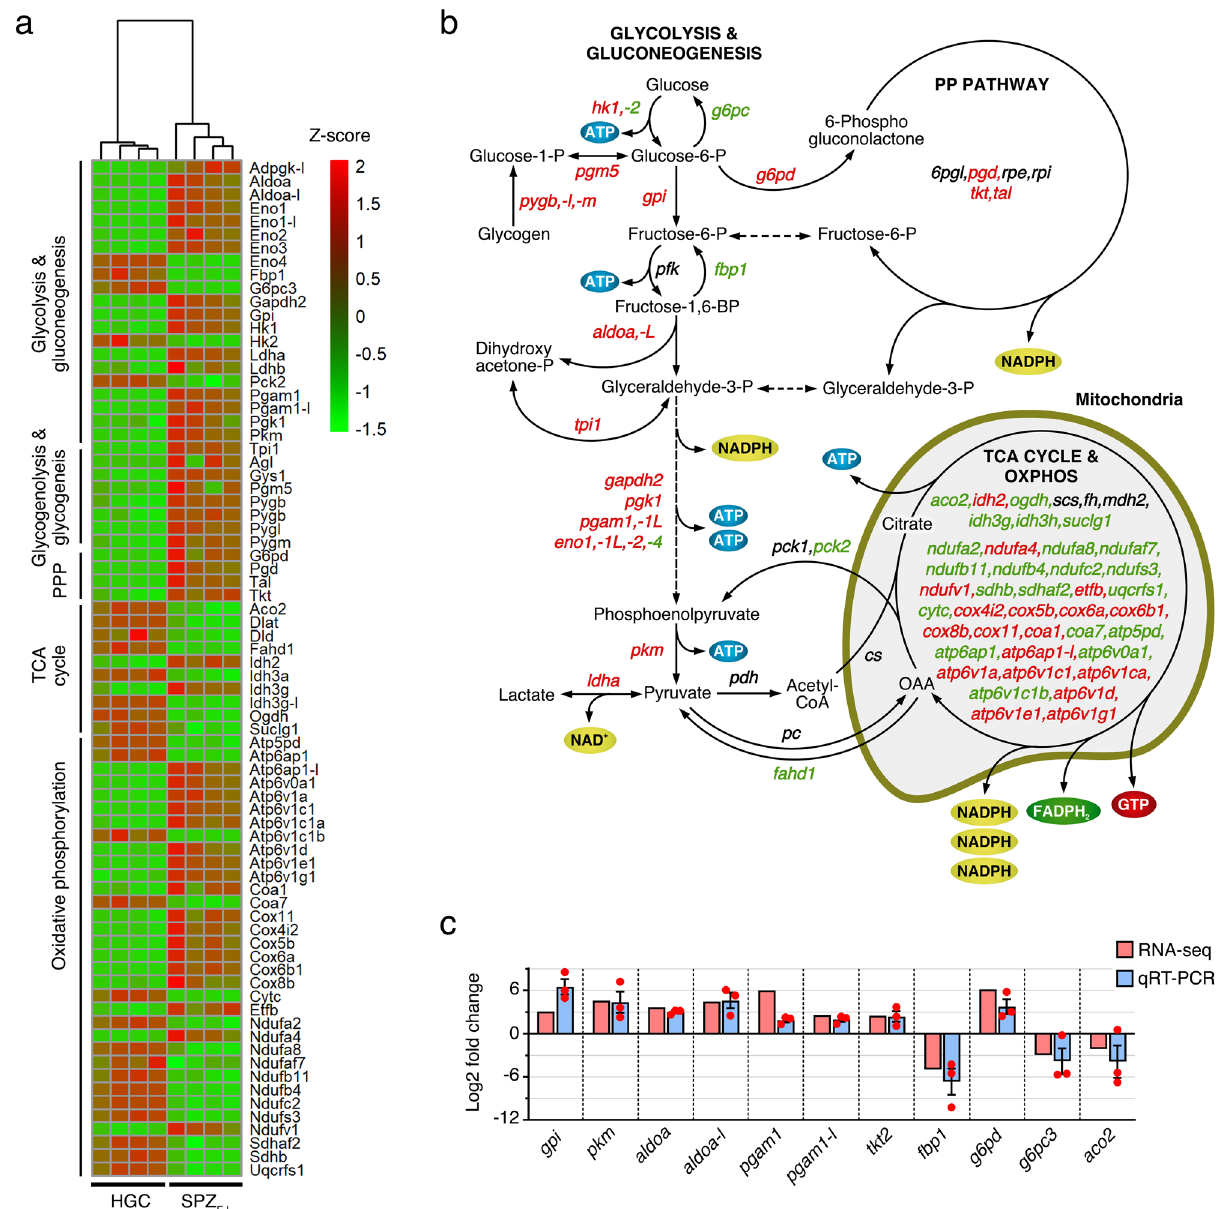
Figure 5. Analysis and mapping of DEGs potentially involved in respiratory pathways in seabream spermatozoa. ( a ) Hierarchical clustering heatmap of RNA-seq expression z-scores computed for genes encoding enzymes potentially involved in carbohydrate metabolism, penthose phosphate pathway (PPP), tricarboxylic acid (TCA) cycle, and oxidative phosphorylation (OXPHOS), that are differentially expressed ( p -adj < 0.01; Log2 fold change > 1) between HGC and SPZ EJ . The map was generated with the ‘pheatmap’ R package (https:// CRAN.R- proje ct. org/ packa ge= pheat map). ( b ) Schematic diagram of the biochemical pathways of glycolysis/ gluconeogenesis, PPP, TCA cycle and OXPHOS. Enzyme-coding DEGs in green and red color denotes downregulation and upregulation, respectively, whereas black color indicates no change in the expression levels. The diagram was generated using CorelDRAW Graphics Suite 2021.5 (https:// www. corel draw. com/). ( c ) Validation of the changes in expression of 11 selected genes classified into respiratory pathways by qRT- PCR. Data from qRT-PCR are the mean ± SEM ( n = 3 pools of 3 different fish each) and were plotted using the GraphPad Prism v8.4.3 (686) software (https:// www. graph pad.